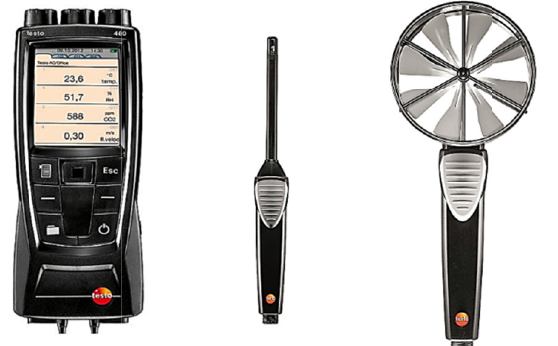
Fig. 3. The device which is used to measure air humidity, temperature and velocity